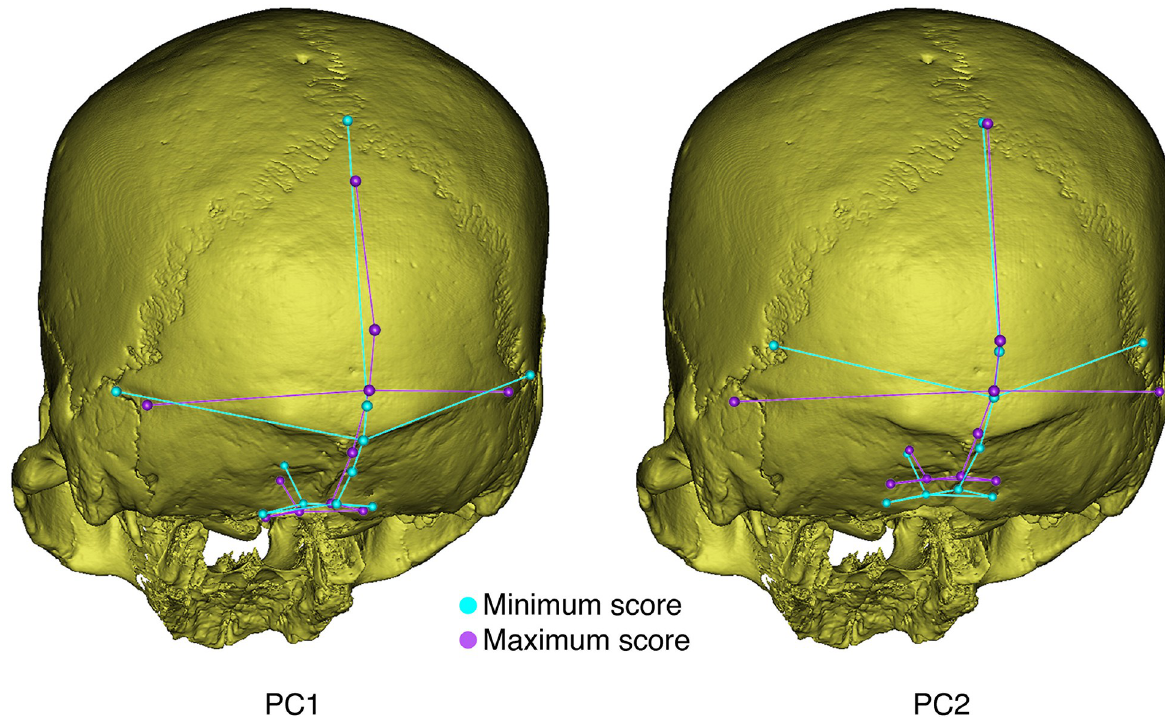
Fig 5. Shape change along PC1 and